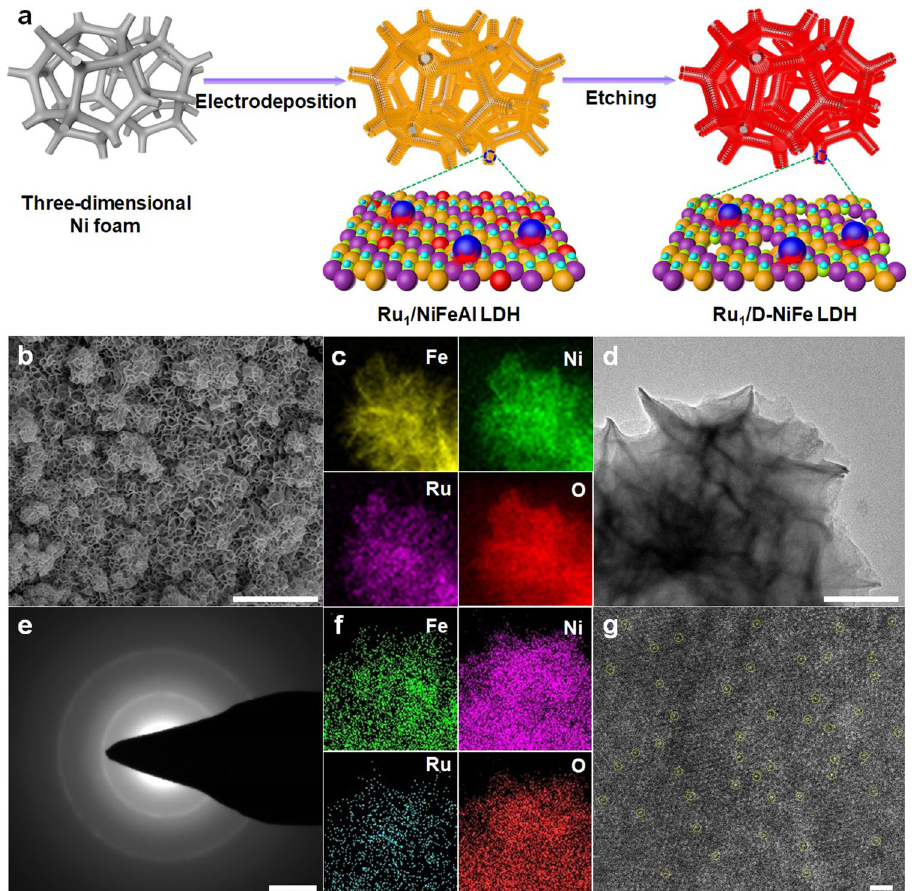
Fig. 1 Schematic representation of synthesis and morphological characterizations. a Synthesis illustration and b SEM image, d TEM image, e SAED pattern, and g aberration-corrected TEM image of Ru 1 /D-NiFe LDH (isolated Ru atoms are marked with yellow circles), (cf) elemental mapping of c HAADF-STEM and f aberration-corrected TEM images of Ru 1 /D-NiFe LDH. Scale bar, b 1 μ m, d 200 nm, and g 1